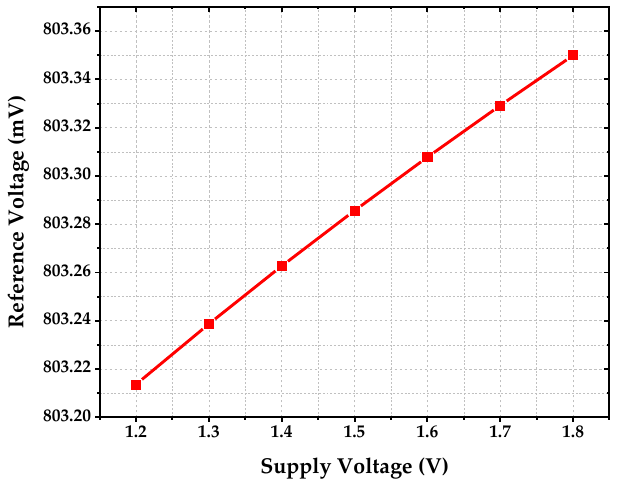
Figure 14. Line Sensitivity of Proposed Reference Circuit from 1.2 V to 1.8 V.